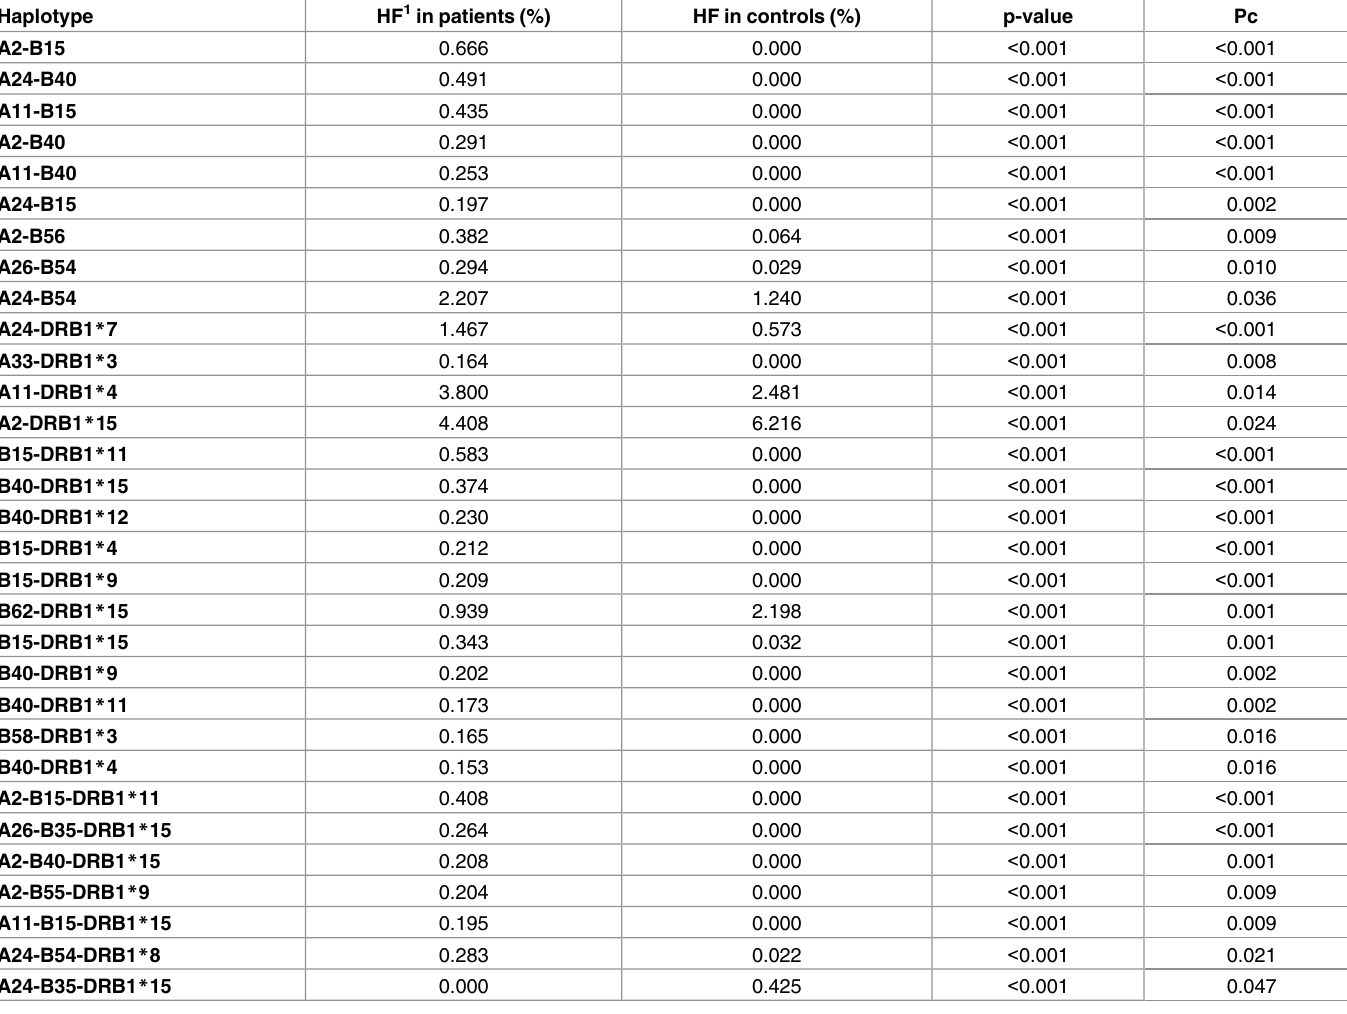
Table 3. The haplotypes with significantly different frequencies between uremia patients and healthy